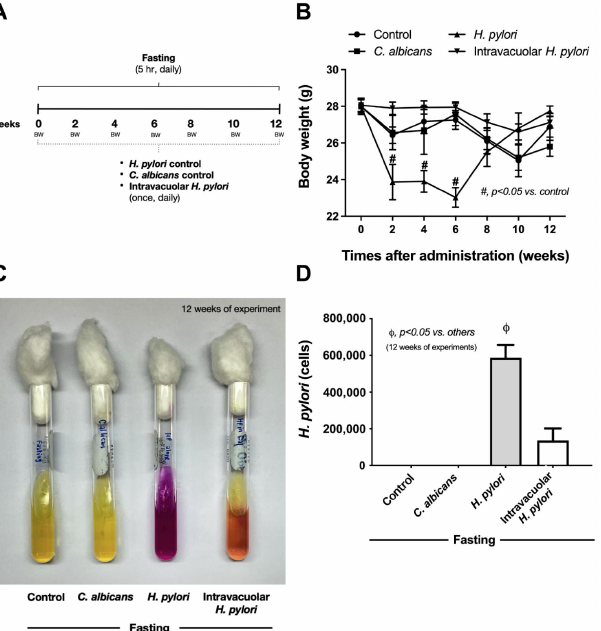
Figure 5. Characteristics of gastritis in mice after intravacuolar H. pylori administration. The schema of the experiments indicates the once-daily oral administration of 1× phosphate buffer solution (PBS) control, C. albicans alone, H. pylori alone, or Candida containing H. pylori for 12 weeks ( A ). The time-points of weight loss (%) of the mice in each group ( B ) and the abundance of H. pylori in the stomach at 12 weeks post-experiment, as indicated by the representative pictures of the urea-based culture ( C ) and CagA -gene expression ( D ) are shown (n = 6 – 9/group). #, p < 0.05 vs. control; ϕ , p < 0.05 vs. others, as calculated by ANOVA with Tukey’s analysis.